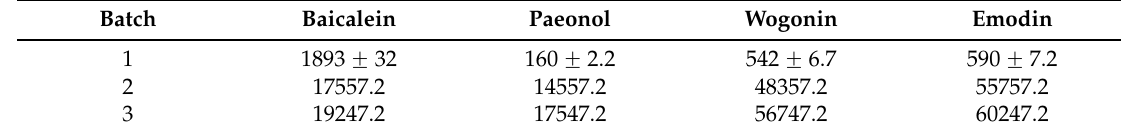
Table 3. Contents of baicalein, paeonol, wogonin and emodin in HGKYC ( µ g/g, n = 3, mean ˘